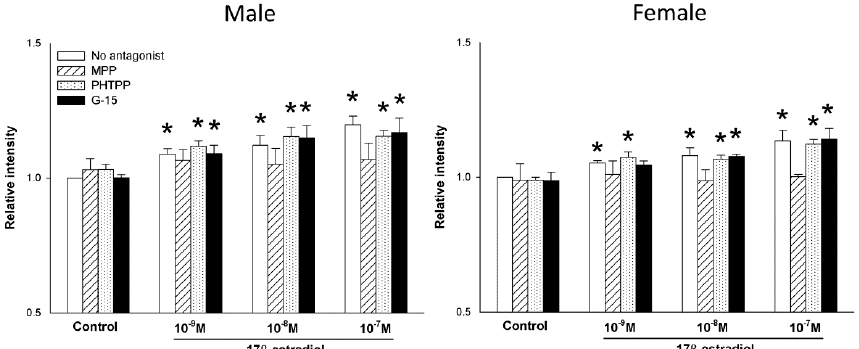
Figure 5. H 2 O 2 level in cells derived from male and female rat thyroid. Cells were incubated in the presence of 17 β -estradiol (0.0 nM, 1.0 nM, 10 nM or 100 nM) alone or with addition of one of the 17 β -estradiol receptor antagonists (10 µM). The level of H 2 O 2 was evaluated by Premo ™ cellular hydrogen peroxide sensor and was expressed relative to the untreated control group. Bars represent the mean ± SE of three independent experiments. * p < 0.05 vs. respective Control antagonist (without 17 β -estradiol).